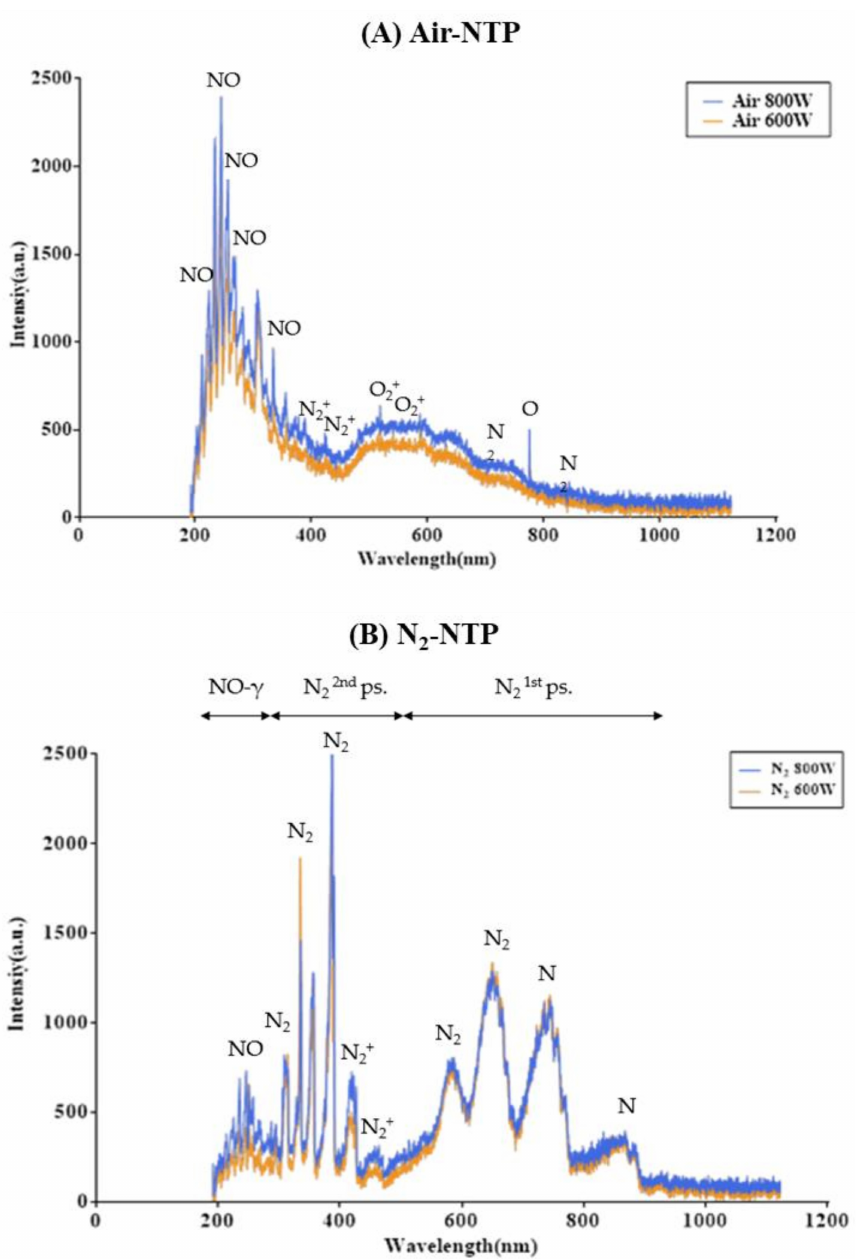
Figure 1. Optical analysis of NTP and djulis seeds: ( A ) the OES (optical emission spectroscopy) spectrum after air atmospheric plasma (air-NTP) and ( B ) the OES spectrum after nitrogen gas atmospheric plasma (N 2 -NTP)